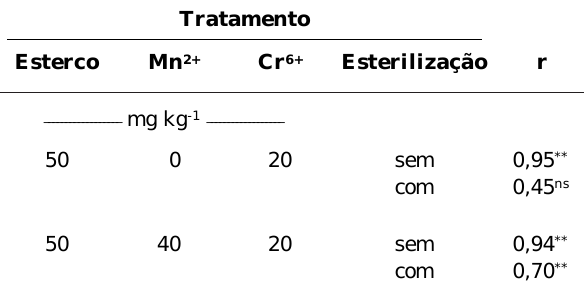
Quadro 3. Coeficientes de correlação entre os teores de Mn 2+ e Cr